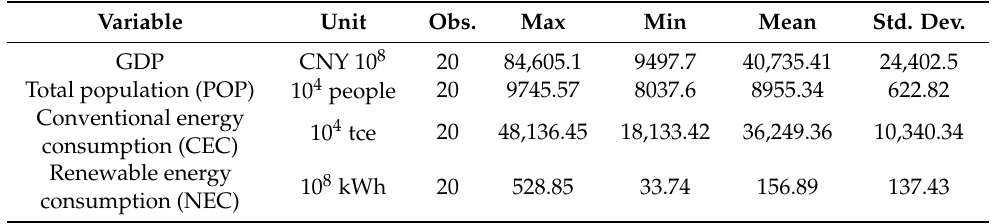
Table 1. Descriptive statistics.